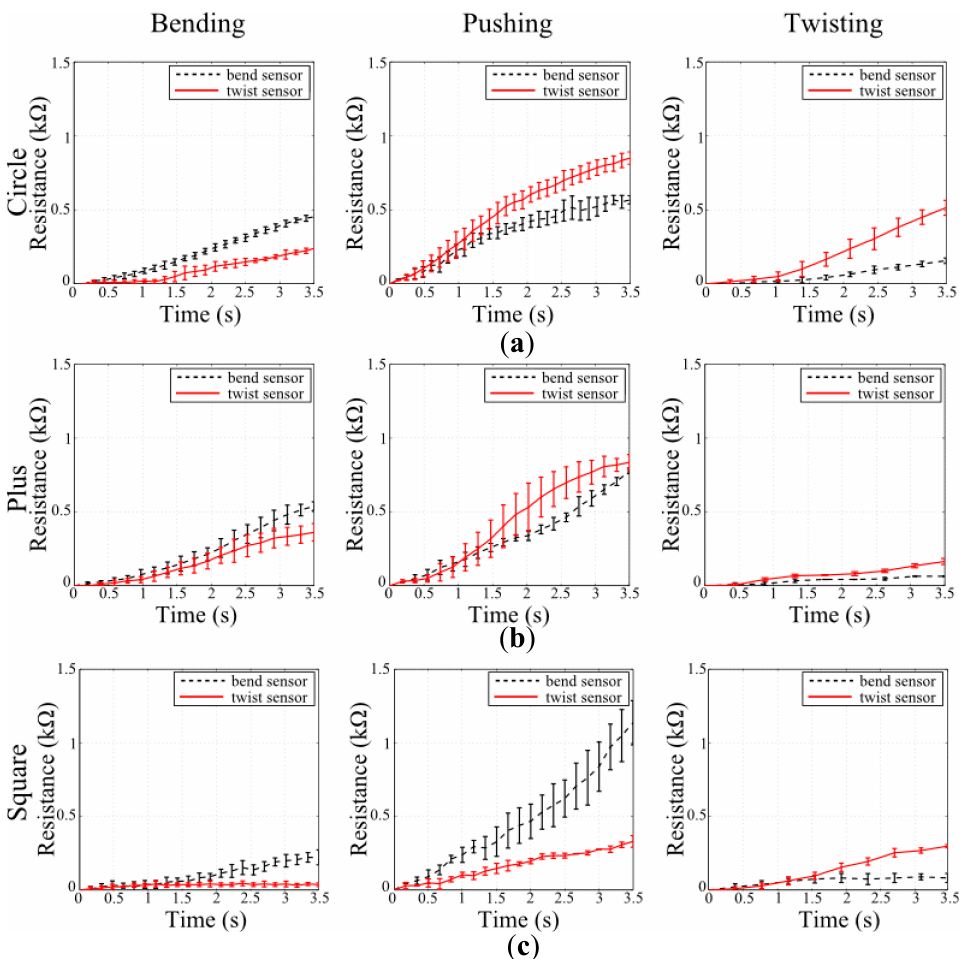
Figure 7. Experimental results of designed sensors for bending and twisting deformations on different structure shapes. In every shape, two sensor designs; i.e. , bend and twist sensors, are tested for three deformations. While each row shows the experiments on structure shapes, every column shows the deformation type. Experimental setup provides steps of stimulus increase for every 0.5 s during deformations; 1 N for bending and pushing, and 1 Nmm for